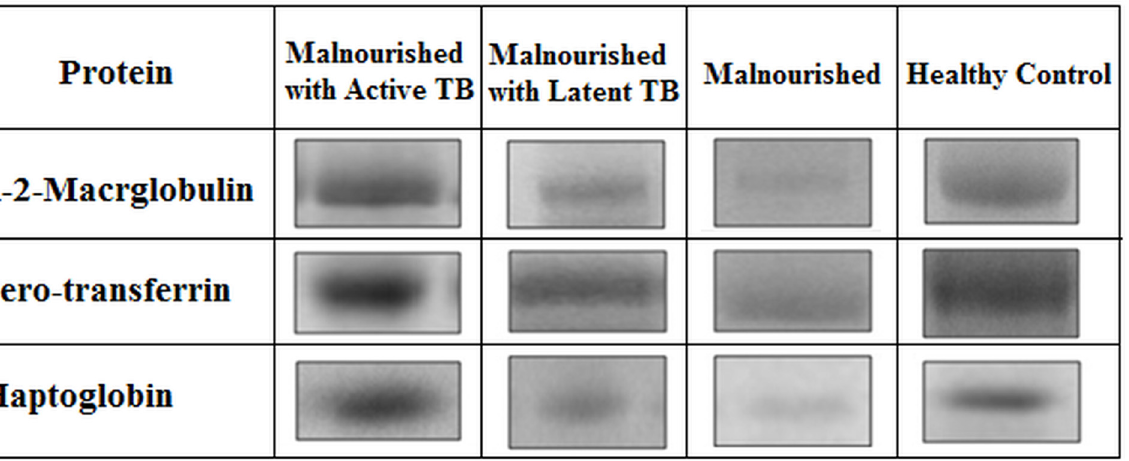
Fig 4. Representative 1-DE gel images of identified proteins in different categories. Boxes indicate the differentially expressed protein bands in different study groups. Gel imaging and analysis was done using Image Lab software (version 4.0, BioRad). The protein bands in the test groups were compared against healthy control